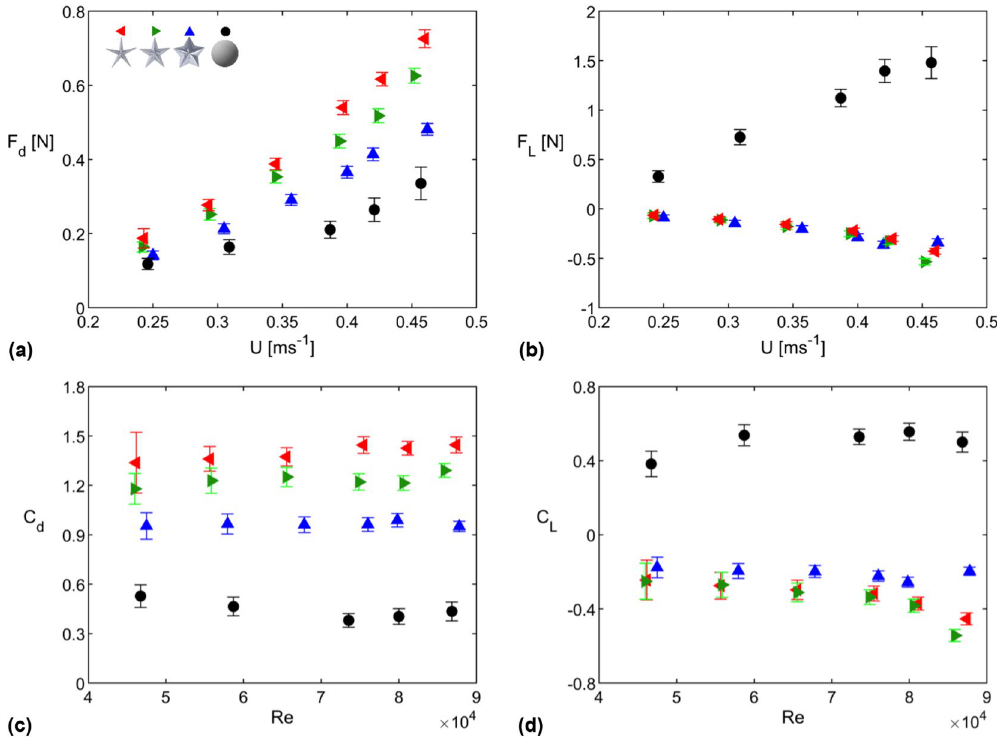
Figure 1. Mean ( a ) drag force, ( b ) lift force, ( c ) drag coefficient, and ( d ) lift coefficient values for sea star and spherical dome models shown as functions of freestream velocity ( a , b ) and Reynolds number ( c , d ). The sea star models have aspect ratios AR = 4.0 (red symbols), 2.5 (green symbols), and 1.5 (blue